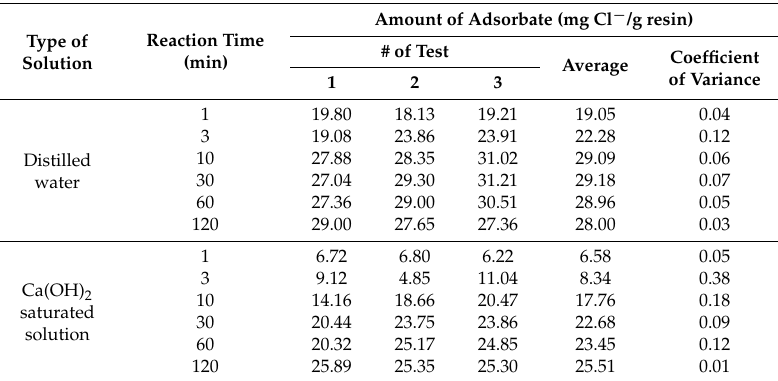
Figure 5. Results of the equilibrium test—linear curve: ( a ) Langmuir isotherm equation; ( b ) Freundlich isotherm equation; and ( c ) Langmuir isotherm equation (curve fitting range: 0 to 5000 mg/L). Table 6. Experimental results of the kinetic test.